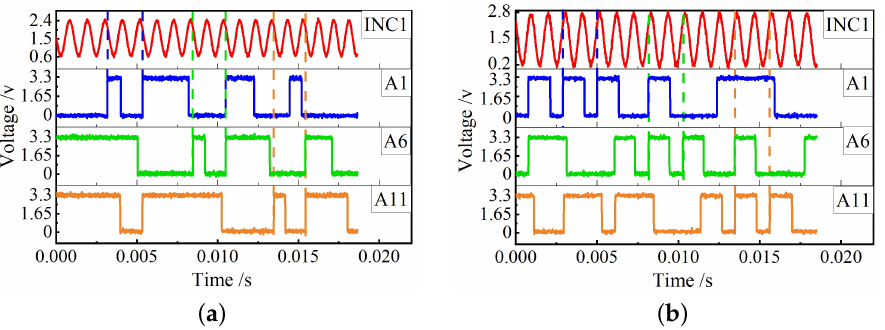
Figure 9. ( a ) Signals output by A1, A6 and A11 channels when LED luminous intensity decreases. ( b ) Signals output by A1, A6 and A11 channels when LED luminous intensity increases.